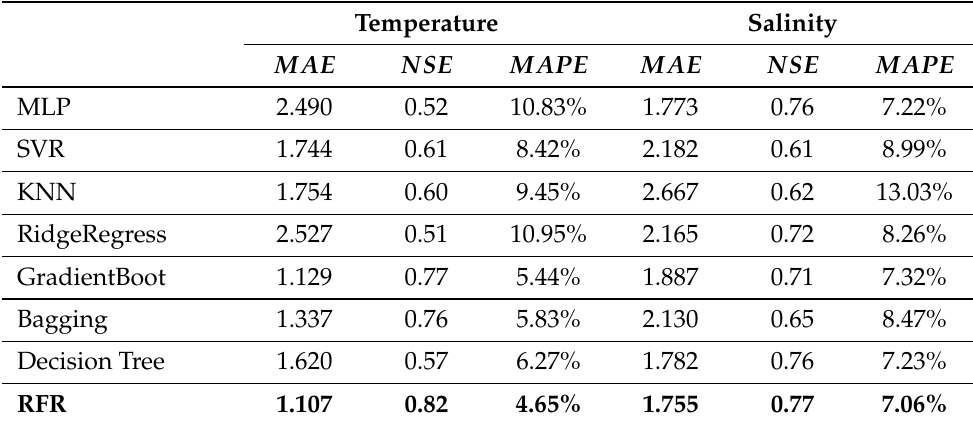
Table 5. Evaluation results for predicting nearshore water